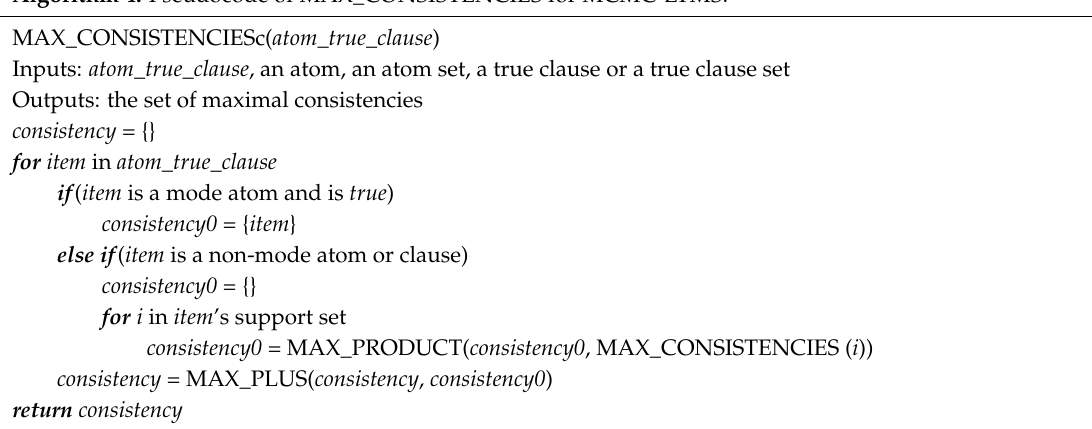
Algorithm 4. Pseudocode of MAX_CONSISTENCIES for